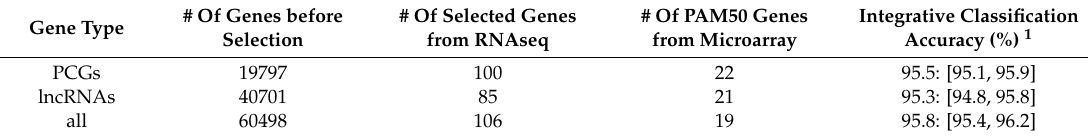
Table 1. Subtype prediction accuracy for integrative gene signatures with PAM50. Gene